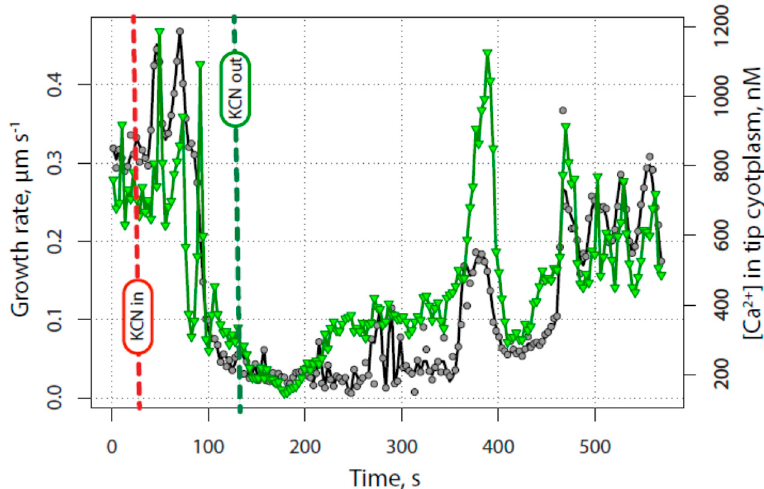
Figure 5. Cytoplasmic [Ca 2+ ] time course—representative experiment showing the effect of transient exposure to 200 µM KCN on pollen tube growth ( black circles) and the concentration of free calcium (as measured by the fluorescence ratio of injected fura-2 dextran) in the cytoplasm at the tube tip ( green inverted triangles). Note that the calcium concentration follows the growth rate closely as KCN takes effect, except for a sharp spike in calcium that occurred in every experiment about 30 s before growth reached its lowest point. While growth is inhibited, calcium levels stay low (about 200 nM) until there is a sharp rise about two min after growth slows to a minimum. However, growth does not increase at this point. Eventually, growth resumes, often with an isolated burst of growth, as shown here at about 380 s, followed by a resumption of steady growth rate oscillations, at about 460 s in this experiment. Calcium peaks co-occur with growth rate peaks, typically with a short lag.